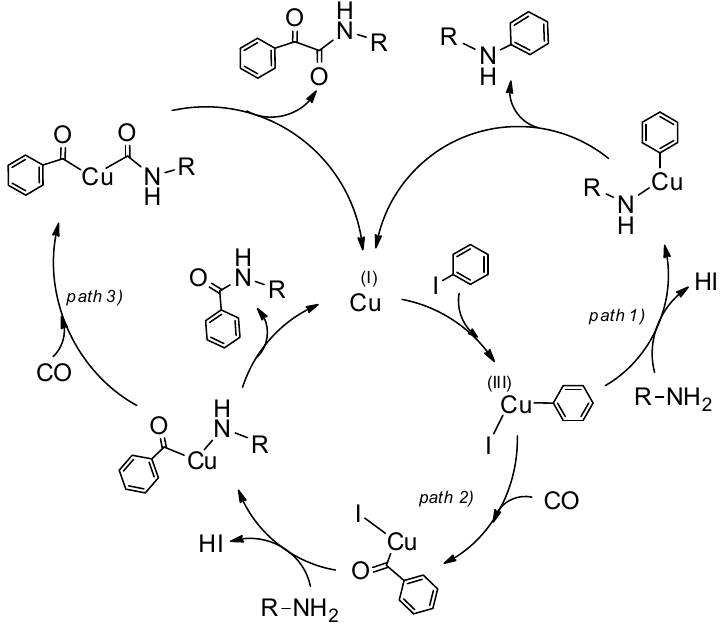
Figure 10. The plausible C–N coupling mechanism.